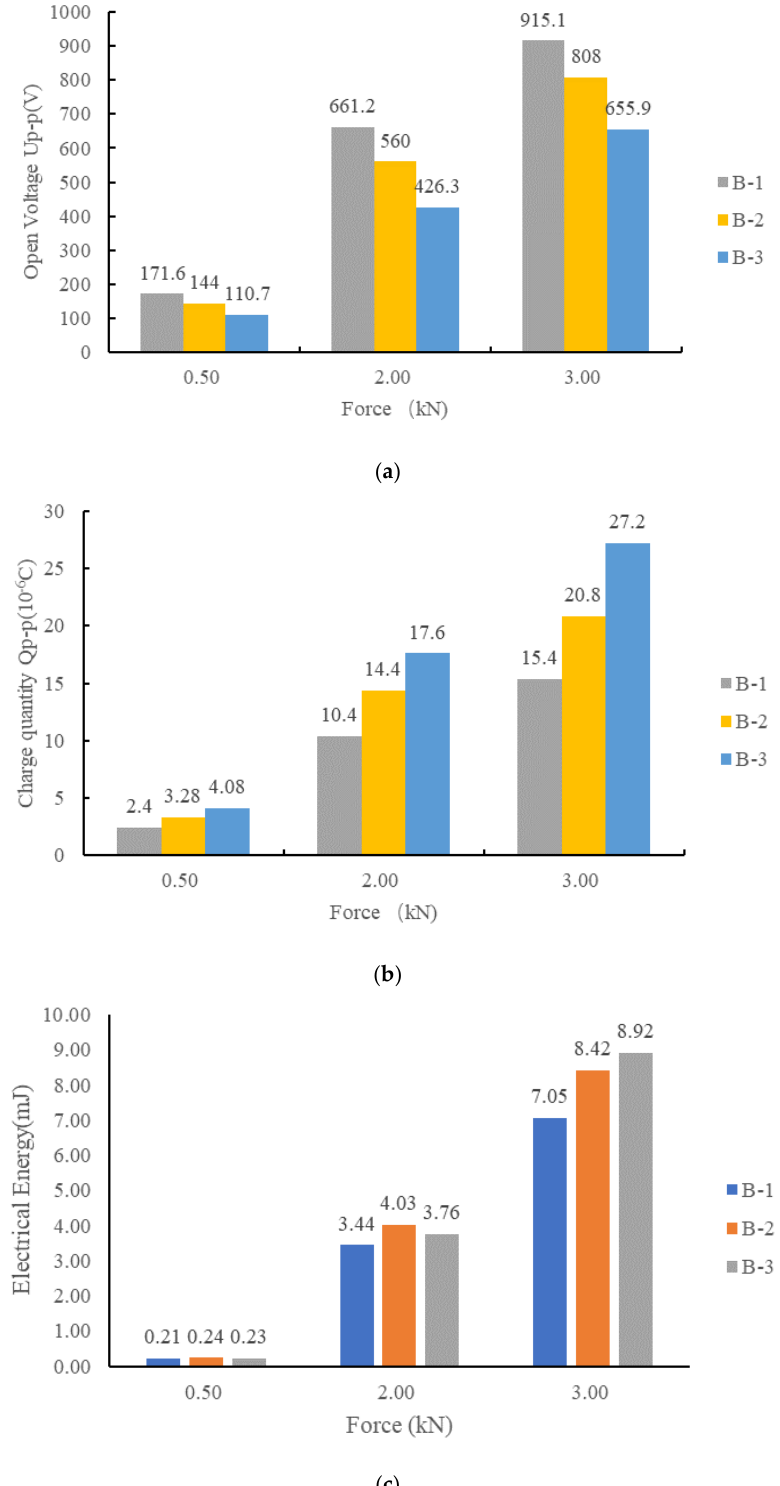
Figure 11. Comparison of electrical properties of stack piezoelectric units with different layers: ( a ) the open peak–peak voltage of B-1, B-2 and B-3; ( b ) charge variation of B-1, B-2 and B-3; ( c ) generated electric energy of B-1, B-2 and B-3.